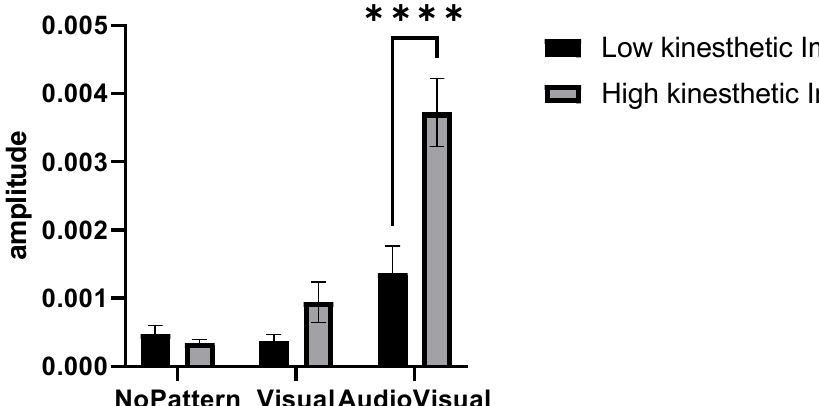
Figure 5. Amplitude of muscle activity in three conditions of No pattern, Visual pattern, and AudioVisual pattern, and in two categories of high and low Visual–kinesthetic imagery ability **** p < 0.0001 .